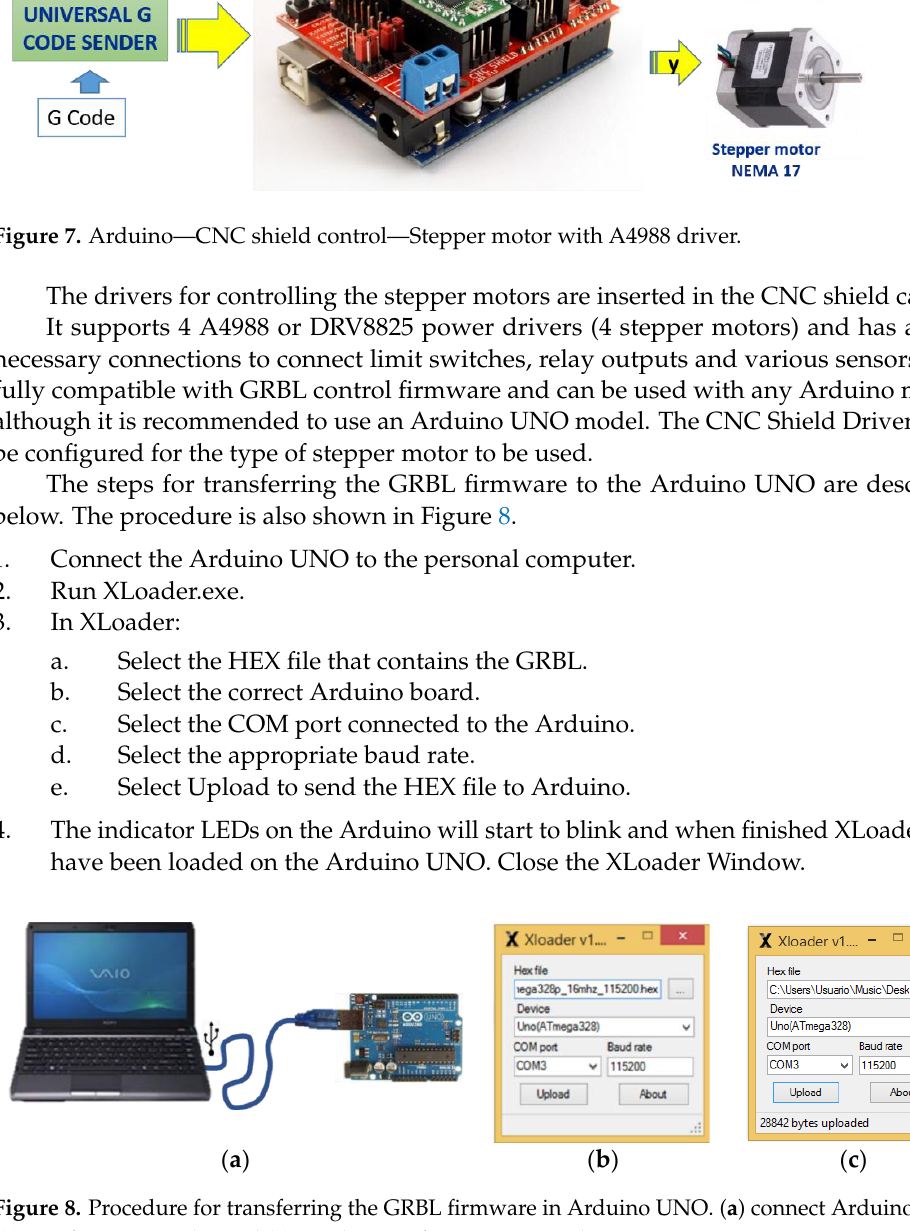
( b ) Figure 6. Workpiece zero point in rehabilitation machines: ( a ) Ankle and ( b ) Shoulder. The hardware and software required for the implementation of CNC, to automate a machine, are shown in Figure 7. It is an Arduino expansion card or module known as CNC shield for the control of a CNC machine. The firmware for the control of CNC ma- chines is loaded on the Arduino board; this firmware was developed by the Norwegian Simen Svale Skogsrud, who is known as the father of GRBL [34]. The GRBL firmware is in charge of translating the G code commands into control signals for the stepper motors.